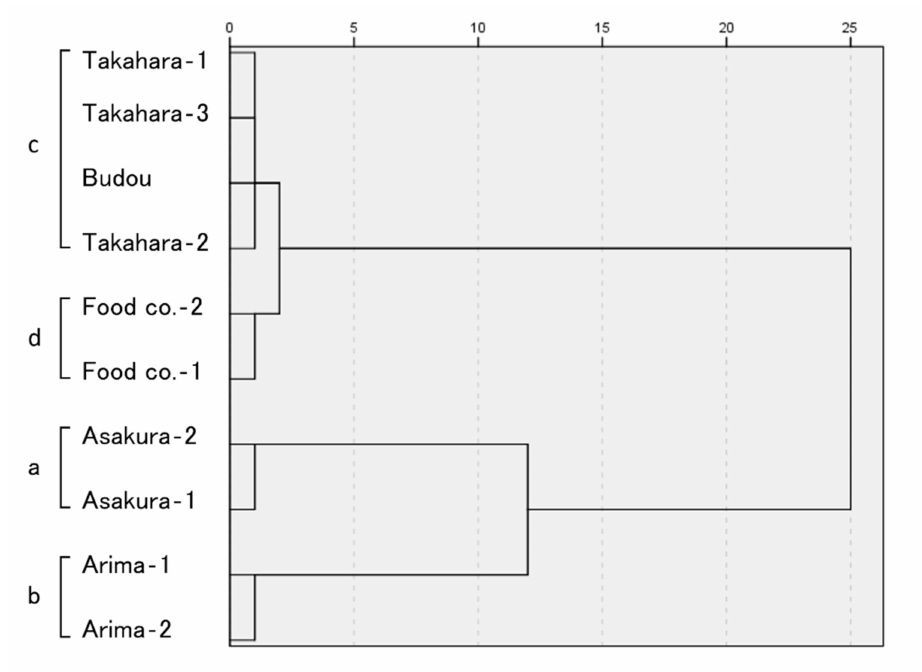
Figure 5. Dendrograms based on sensory evaluation of Japanese pepper. The classification of groups A, B, and E by volatile compound analysis was consistent with the classification based on sensory evaluation. Groups C and D were classified as a single group (Table